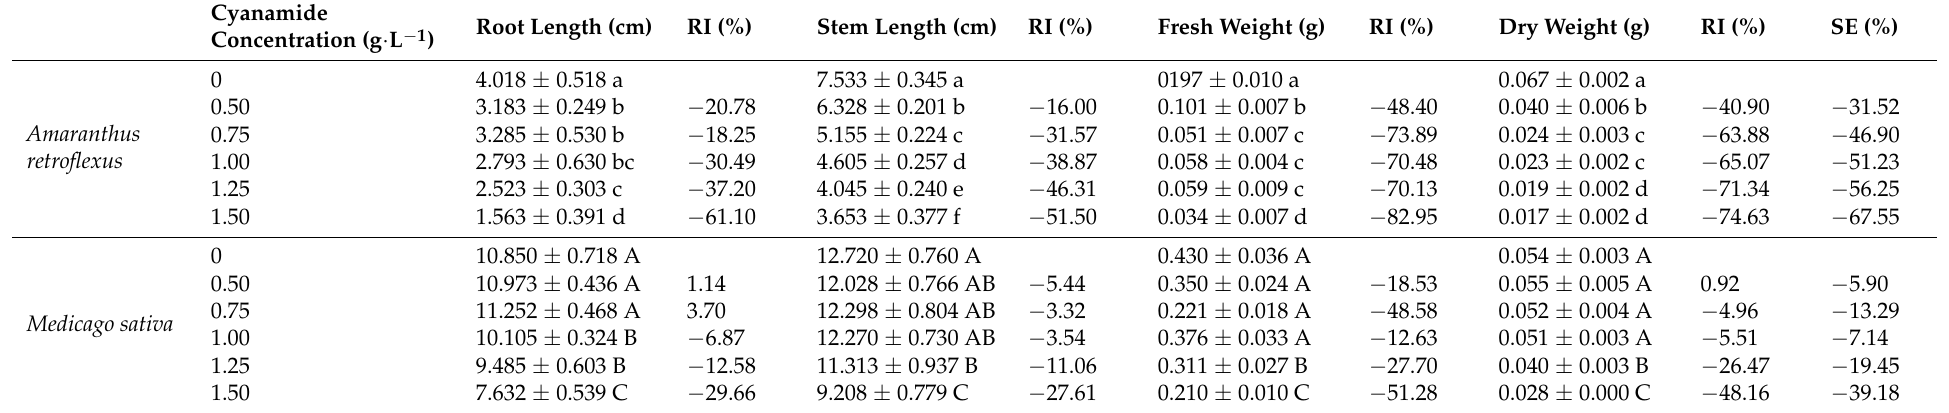
Table 2. Phytotoxic effect of cyanamide on seedling growth of alfalfa and amaranth at different concentration (0, 0.50, 0.75, 1.00, 1.25, and 1.50 g · L − 1 ). Different lower-case letters in columns indicate significant differences among treatments of amaranth at p < 0.05 (LSD test). Different capital letters in columns indicate significant differences among treatments of alfalfa at p < 0.05 (LSD